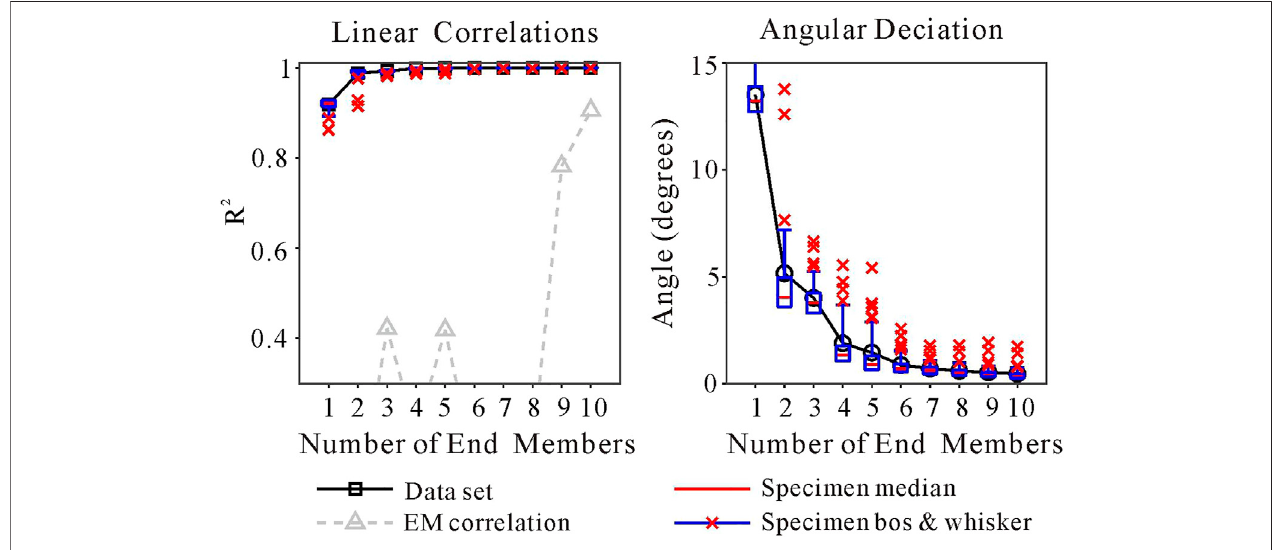
FIGURE 2 | End-member analysis results of XG pro fi